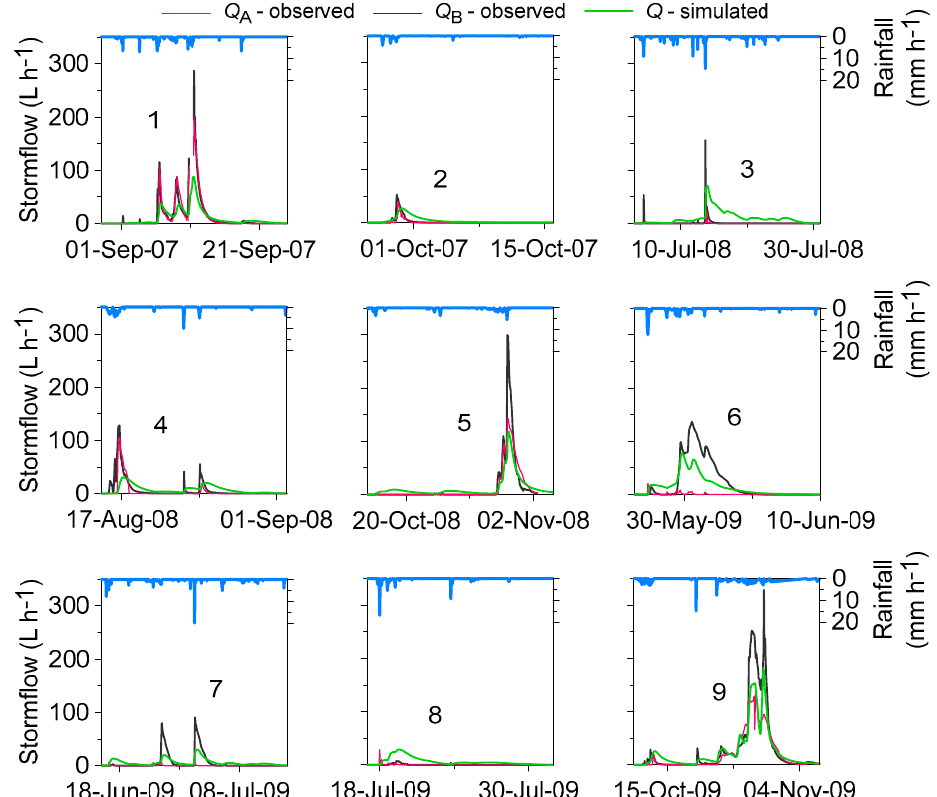
Figure 2. Observed (trench sections A and B) and simulated hillslope discharge hydrographs during selected rainfall–runoff episodes recorded over the period of three years. The rainfall–runoff episodes are marked with numbers. Adopted from Dusek and Vogel [42].